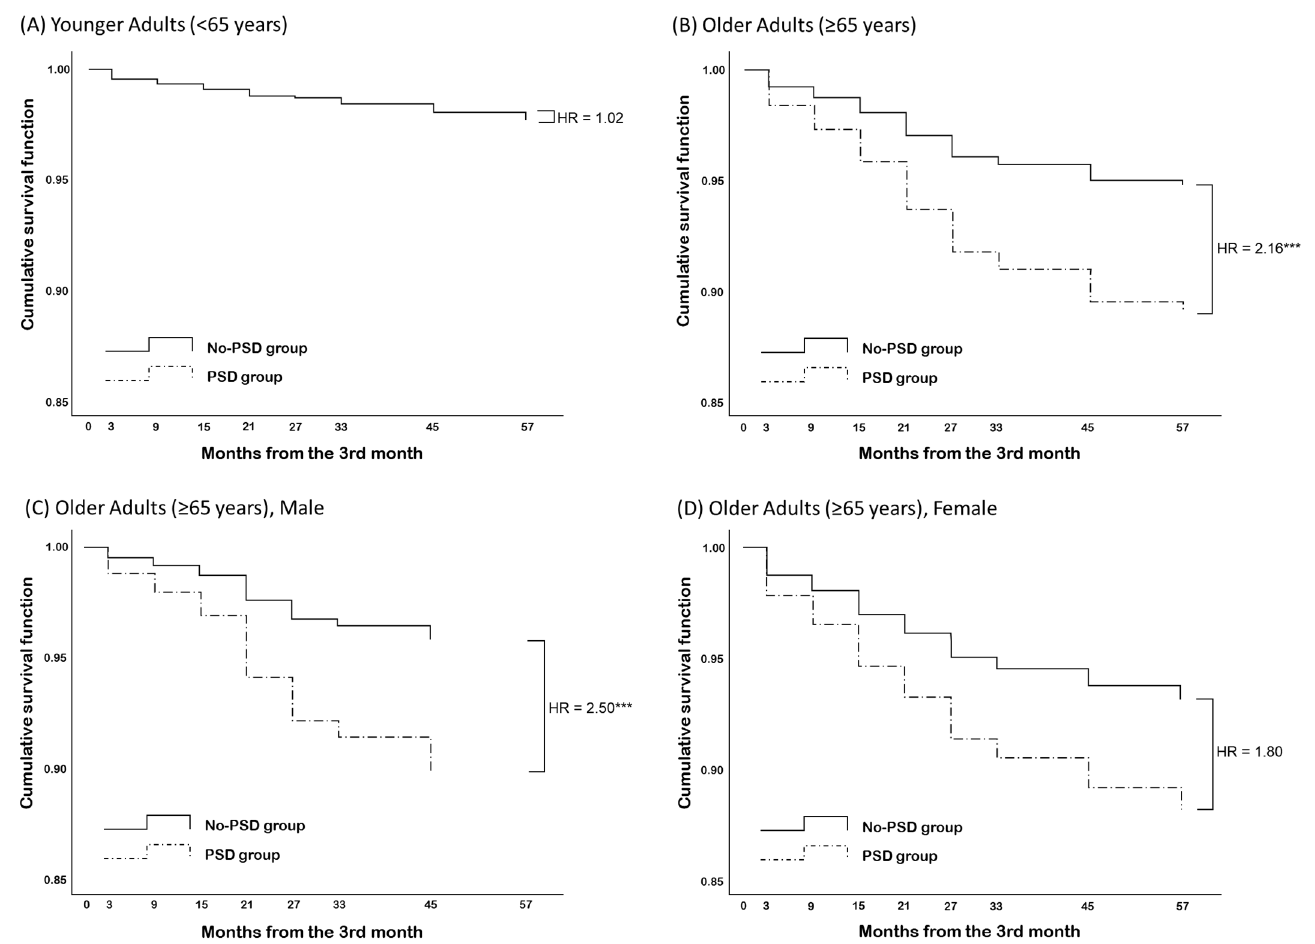
Figure 2. Cumulative survival rates. ( A ) Younger adult patients. ( B ) Older adult patients. ( C ) Older adult patients, male. ( D ) Older adult patients, female. PSD, post-stroke depression; HR, hazard ratio. *** p <